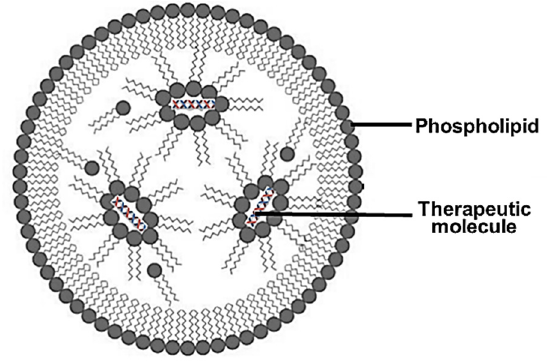
Figure 2. An illustration of a lipid nanoparticle showing the outer phospholipid layer and the encapsulated therapeutics.